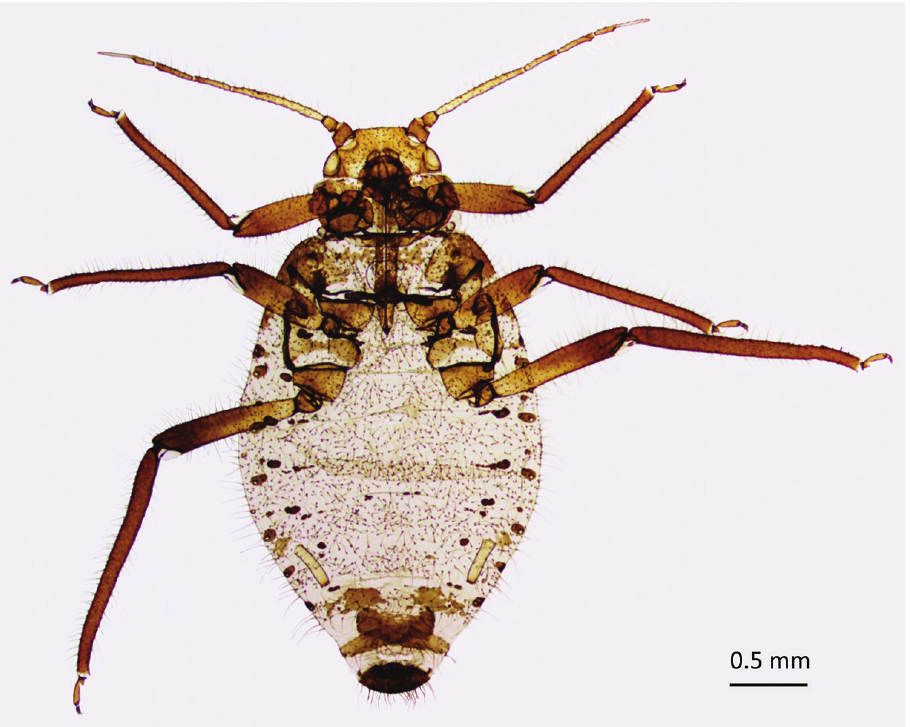
Figure 1. Oviparous female of P. tremulae